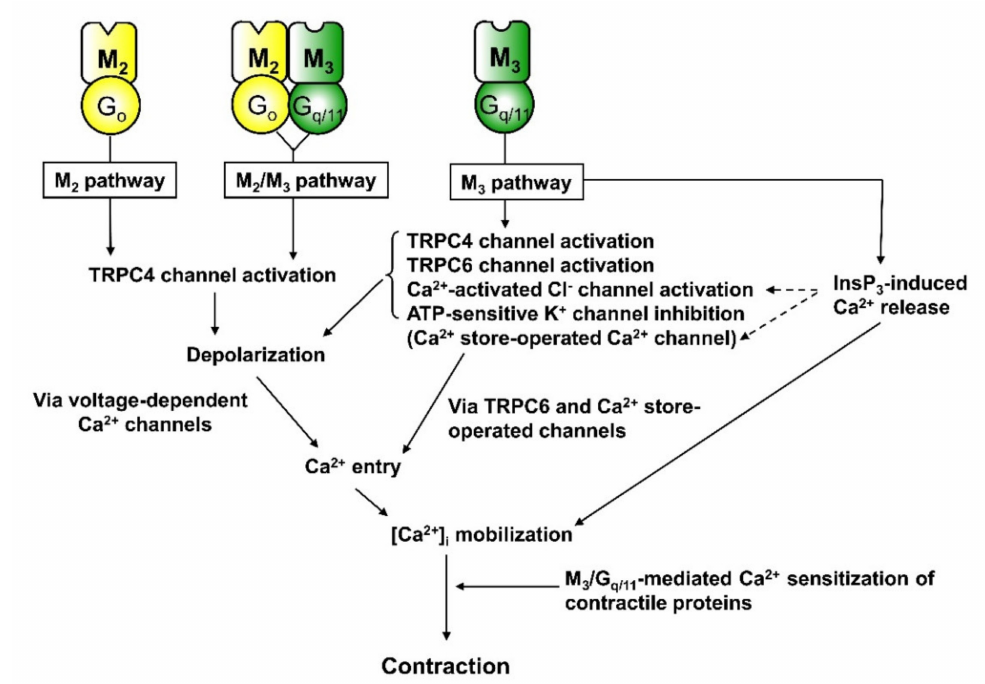
Figure 2. Signal transduction mechanisms underlying muscarinic contraction of mouse intestinal smooth muscle. The M 3 pathway activates multiple intracellular Ca 2+ mobilisation events, including Ca 2+ influx via VDCCs and voltage-independent Ca 2+ -permeable channels and intracellular Ca 2+ release. Voltage-dependent Ca 2+ influx is initiated by depolarisation from opening of TRPC4 and TRPC6 cationic channels, opening of Ca 2+ -activated Cl − channels and inhibition of K ATP channels, while voltage-independent Ca 2+ entry is mediated by opening of TRPC6 cationic channels and Ca 2+ store-operated Ca 2+ channels. In addition to Ca 2+ mobilisation, Ca 2+ sensitisation of contractile proteins is elicited, thereby increasing the efficiency of contraction–[Ca 2+ ] i coupling. The M 2 or M 2 /M 3 pathways induce contraction through a simple Ca 2+ mobilisation mechanism in which Ca 2+ entry via VDCCs is activated by TRPC4 channel-induced depolarisation. These pathways play a major role in mediating muscarinic contraction, with the M 2 /M 3 pathway making a relatively